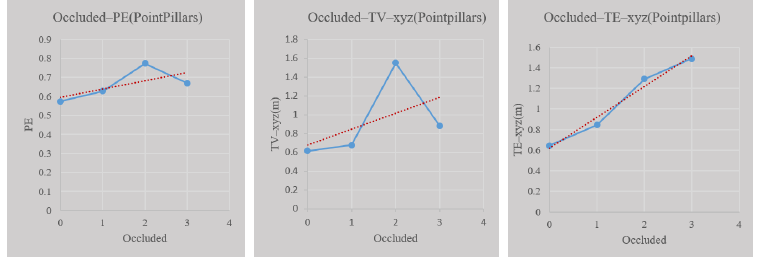
Figure 16. The relationship between object occlusion and perception